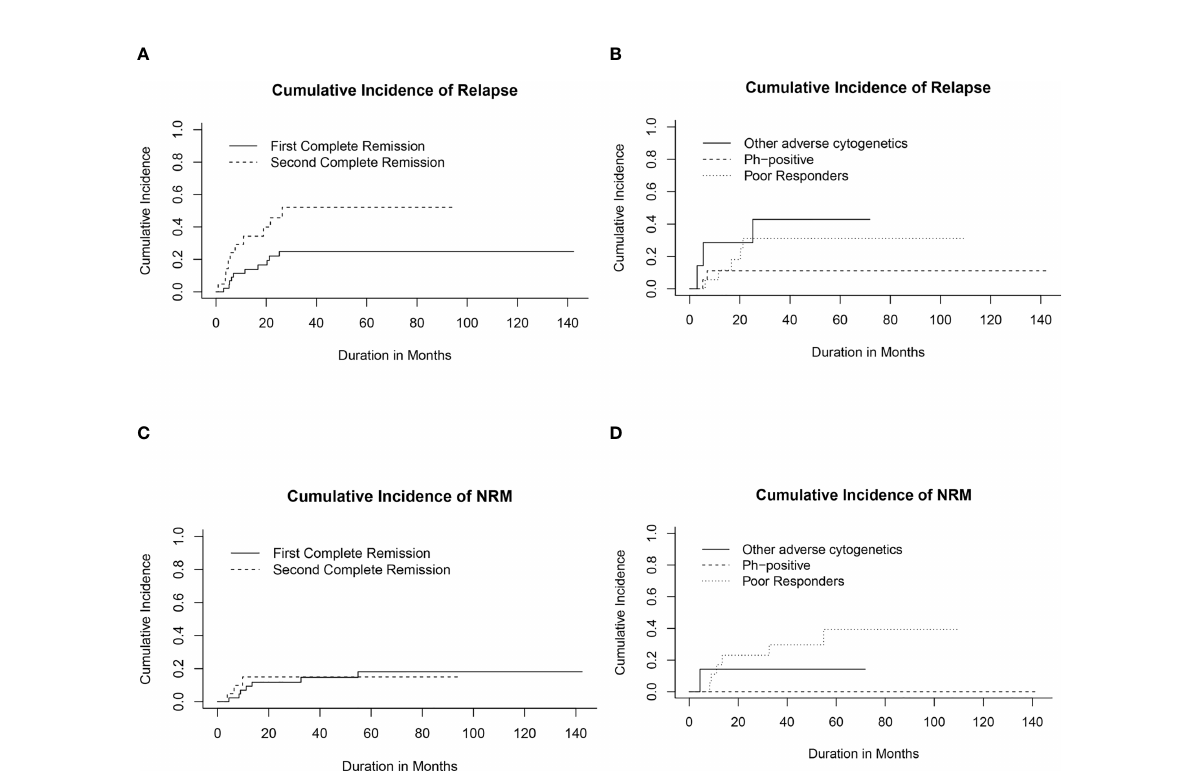
FIGURE 2 Cumulative incidence of relapse (CIR) and non-relapse mortality (CI-NRM). (A) CIR for transplanted patients in fi rst (CR1) and second (CR2) complete remission. (B) CIR in relation to high-risk features in CR1 transplants. (C) CI-NRM for transplanted patients in fi rst (CR1) and second (CR2) complete remission. (D) CI-NRM in relation to high-risk features in CR1